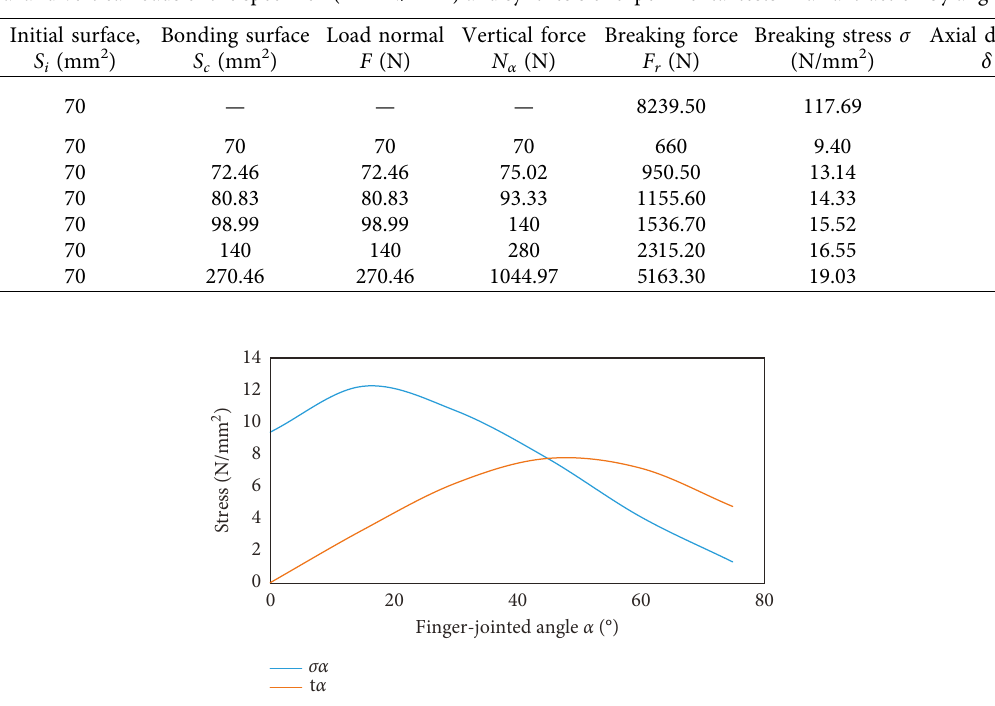
Figure 15: Normal ( σ α ) and tangential ( τ α ) stresses as a function of the angle α .